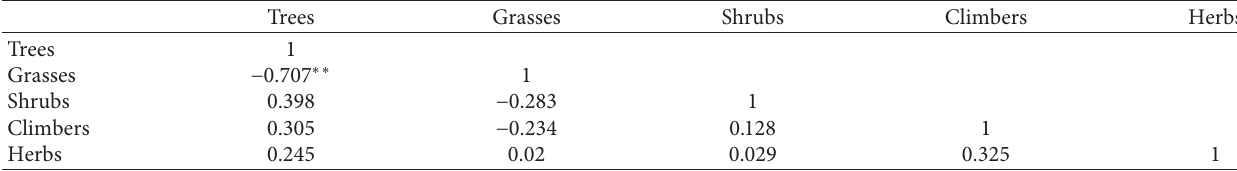
Table 7: Spearman’s rank correlation matrix of Shannon Wiener’s diversity index ( N � 24). Trees Herbs